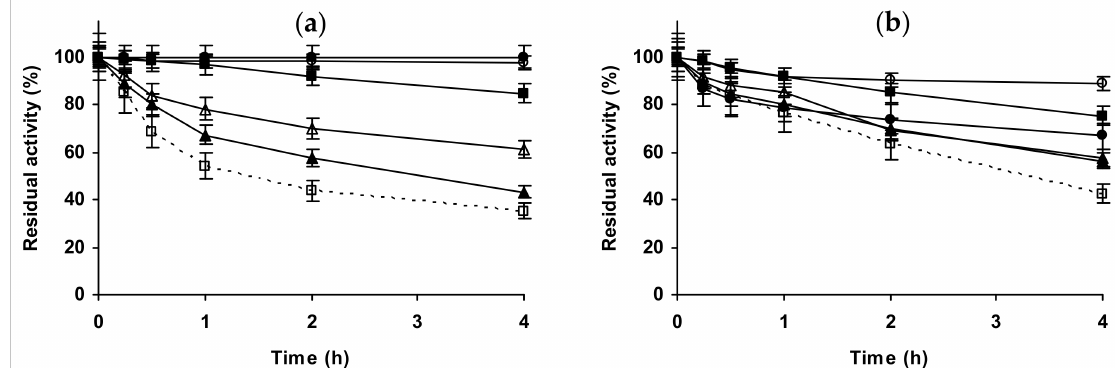
Figure 12. Effect of ionic strength and inactivation pH on the stability of glutaraldehyde- β -glucosidase. ( a ) pH 5.0 and 54 ◦ C; ( b ) pH 7.0 and 62 ◦ C. Other specifications are described in the Methods section. Dotted line, empty squares: references; full triangles: 1 M NaCl; empty triangles: 3 M NaCl; full circles: 1 M (NH 4 ) 2 SO 4 ; empty circles: 3 M (NH 4 ) 2 SO 4 and full squares: 1 M Na 2 SO 4 .